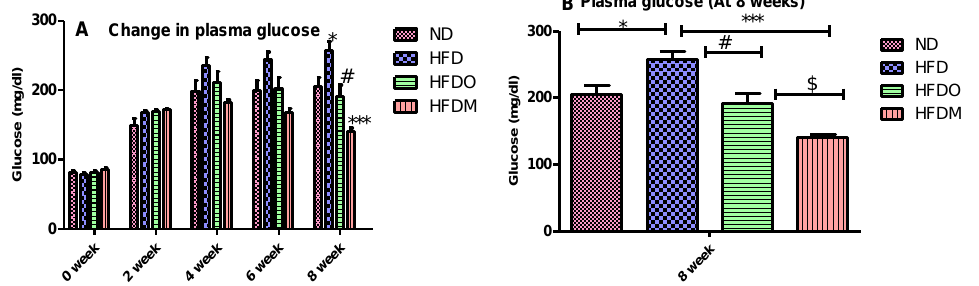
Figure 7. Treatment with MESK reduced the high-fat diet-induced hyperglycemia in the diet-induced obese mouse model. ( A ) Bar graphs representing the changes in glucose levels during the 8-week study period. ( B ) Change in plasma glucose level after the eighth week. (N = 5, * p = 0.0114 between ND and HFD, # p = 0.0114 between HFD and HFDO, $ p = 0.0167 between HFDO and HFDM, *** p < 0.001 between HFD and HFDM). Data are represented as Mean ± SD. (ND: normal diet, HFD: high-fat diet, HFDO: HFD + Orlistat, HFDM: HFD + MESK).